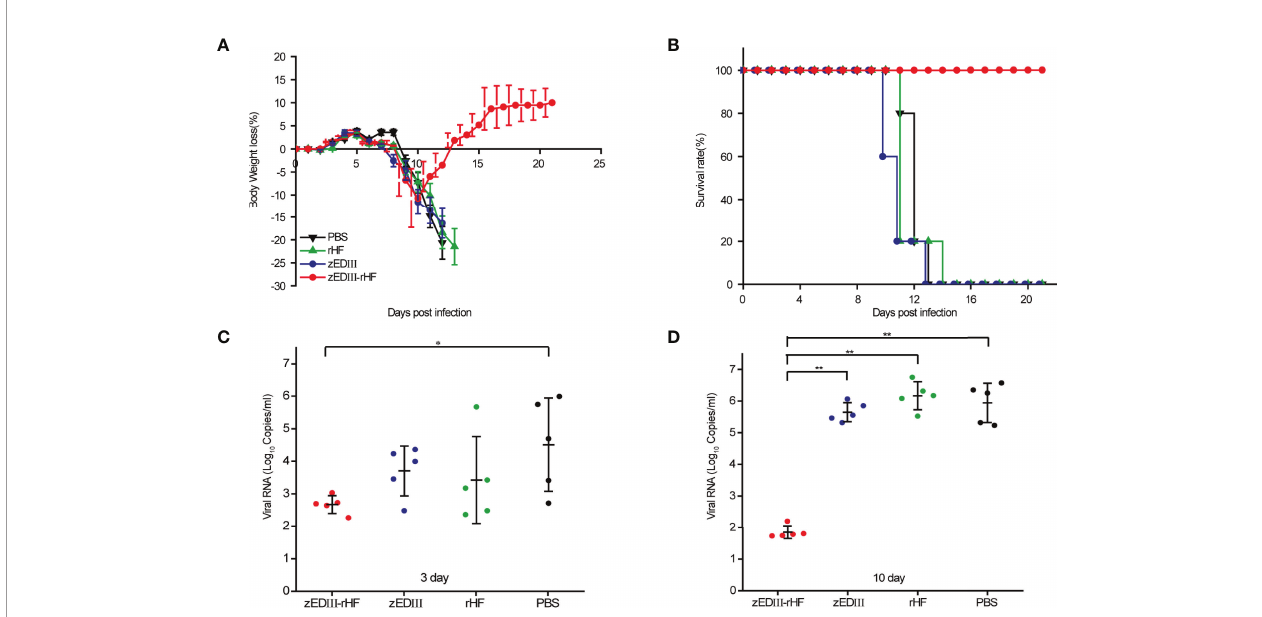
FIGURE 4 | Protective ef fi cacy against ZIKV infection. At two weeks postvaccination, mice were challenged with 20 m l of ZIKV (SZ-WIV01, 10× LD 50 ) by foot pad injection. (A) Body weight changes of mice after challenge, n = 5. (B) Survival rates of mice after challenge, n = 5. (C) ZIKV RNA titers in the serum of mice 3 days after challenge, n = 5. (D) ZIKV RNA titers in the serum of mice 10 days after challenge, n = 5. The data in 4a-4d are shown as the mean and standard deviation (mean ± SD) analyzed by Student ’ s t-test; *P < 0.05, **P <